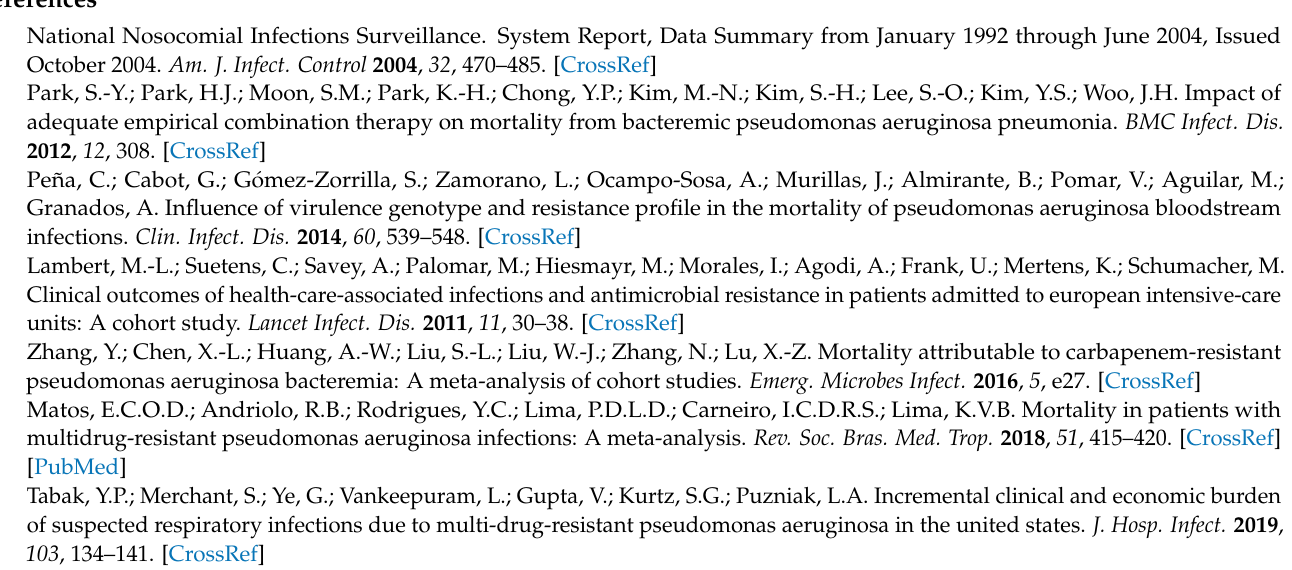
Supplementary Materials: The following are available at https://www.mdpi.com/article/10.3390/ PTA of different regimens in CrCl range of 11–29 mL/min, Table S3: PTA of different regimens in Table S5: PTA of different regimens in CrCl range of 80–100 mL/min, Table S6: PTA of different regimens in CrCl range of 101–130 mL/min.- These are the results of % PTA acquired in different ranges of